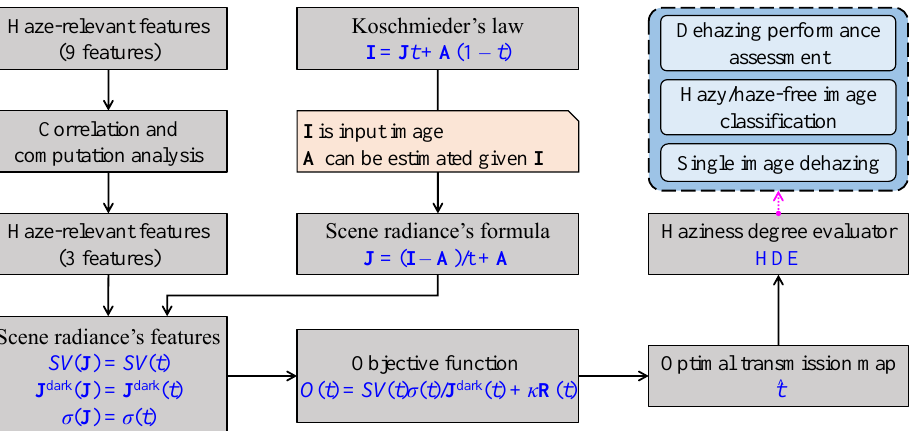
Figure 4. An overview of the proposed haziness degree evaluator’s